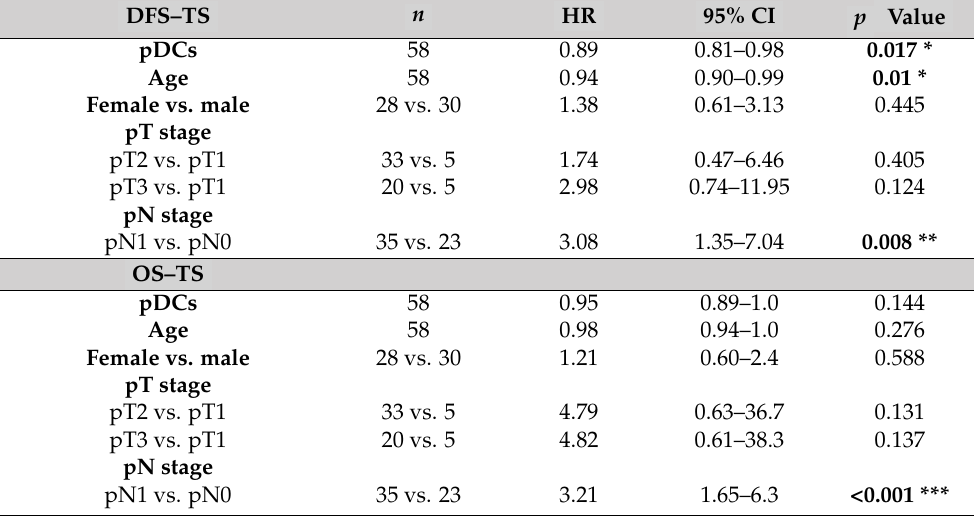
Table 5. Higher densities of tumor stroma (TS)-infiltrating plasmacytoid dendritic cells (pDCs) influence disease-free survival (DFS) but not overall survival (OS). Hazard ratio (HR) and 95% confidence interval (CI) are shown. p ≤ 0.05 was considered